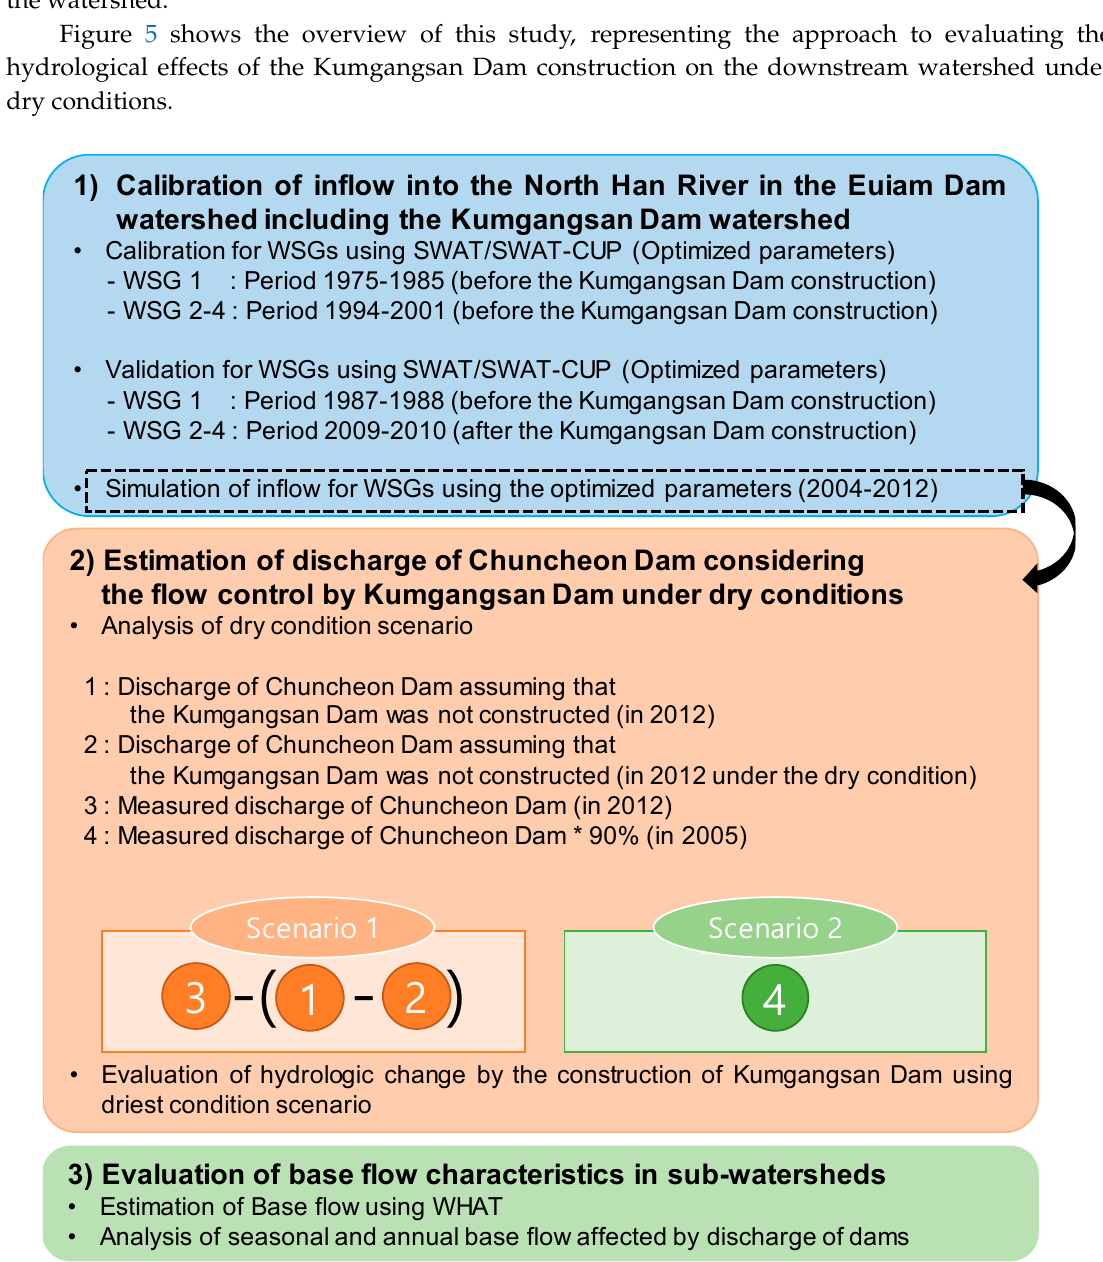
Figure 5. Overview of this study.